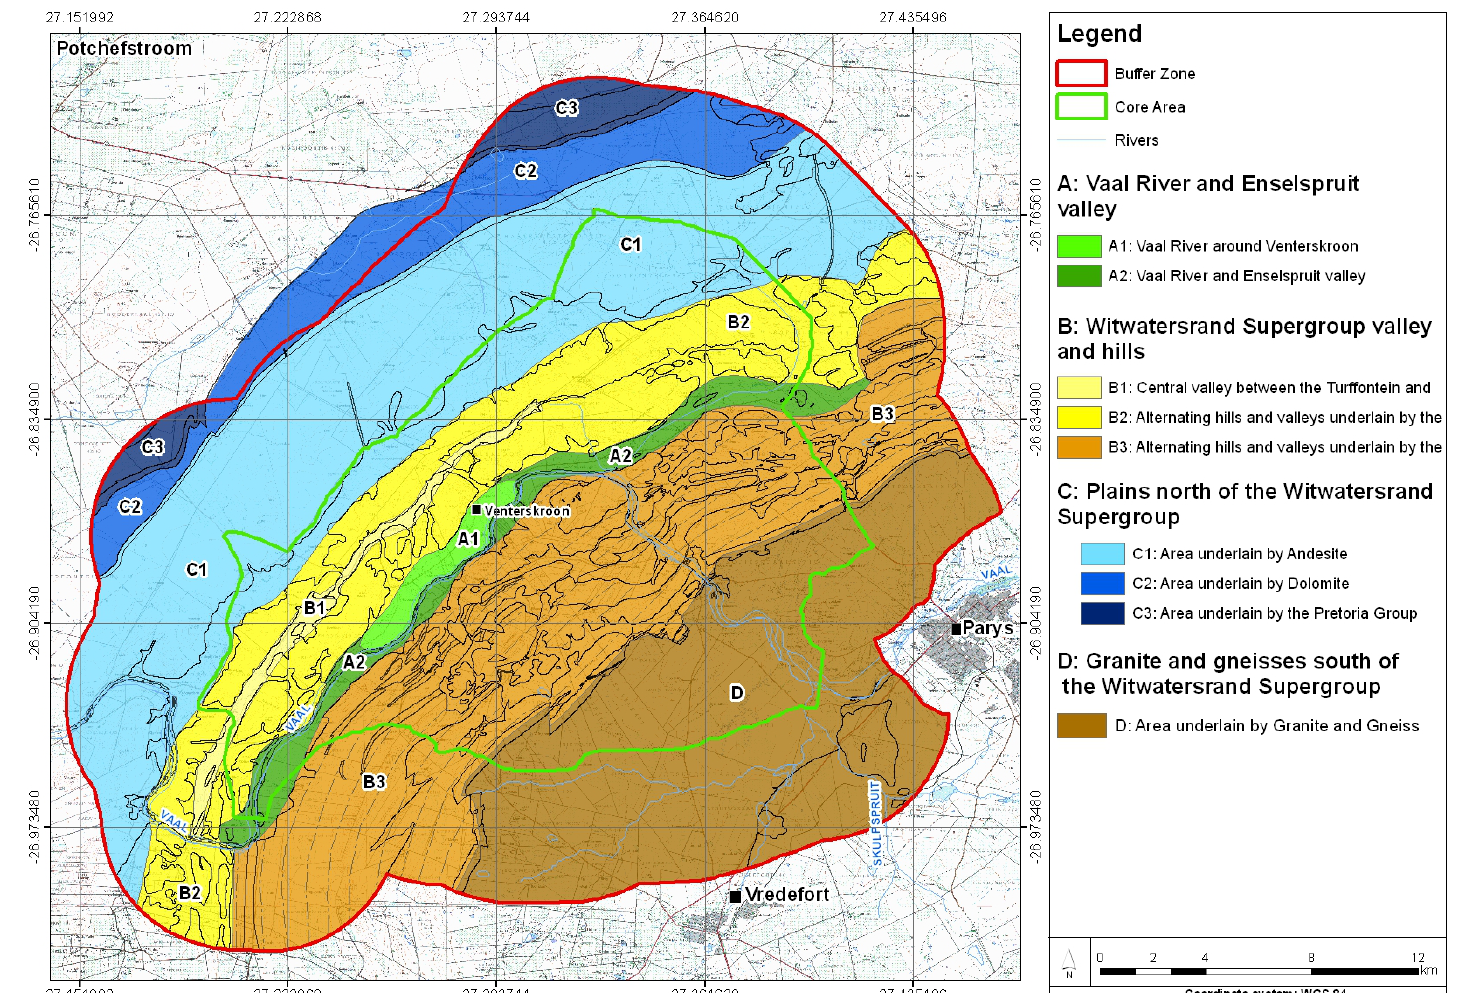
Figure 11. Goundwater resource management units in the